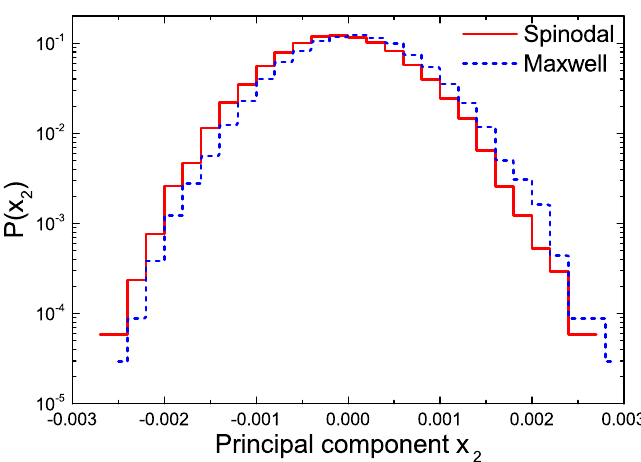
Figure 9 . Distribution functions of the second principal component x 2 for both classes, Maxwell (blue dashed) and spinodal (red solid). One can clearly see the small shift in the mean x 2 and the e(cid:11)ect on the tails of the